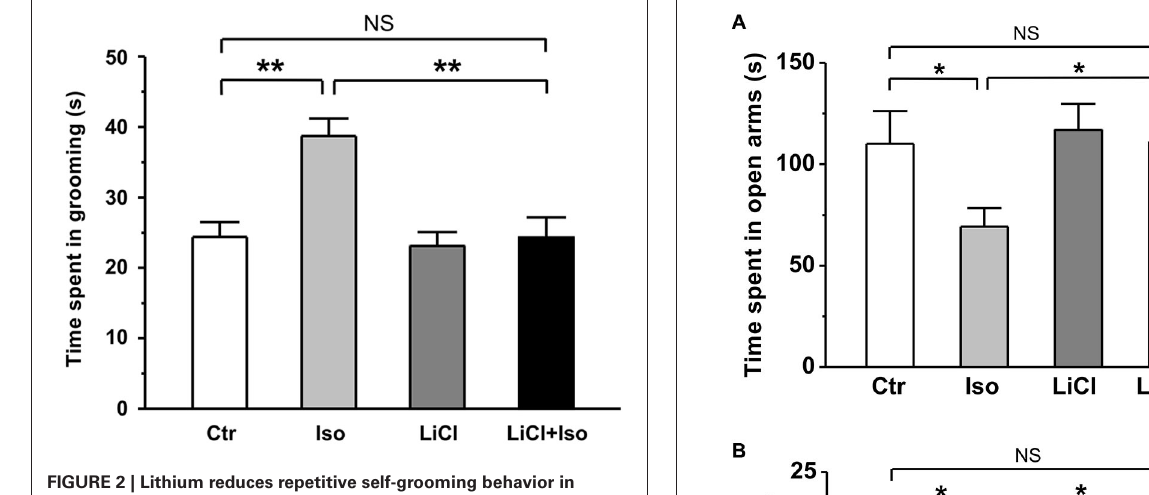
into the open arms (LiCl: 19.1 ± 1.6, p = 0.339 vs. Ctr; LiCl+Iso: 17.3 ± 2.0, p = 0.987 vs. Ctr, p = 0.3317 vs. LiCl, p = 0.015 vs. Iso; Figure 3B ) to control levels, indicating chronic lithium administration overcome neonatal isolation-induced